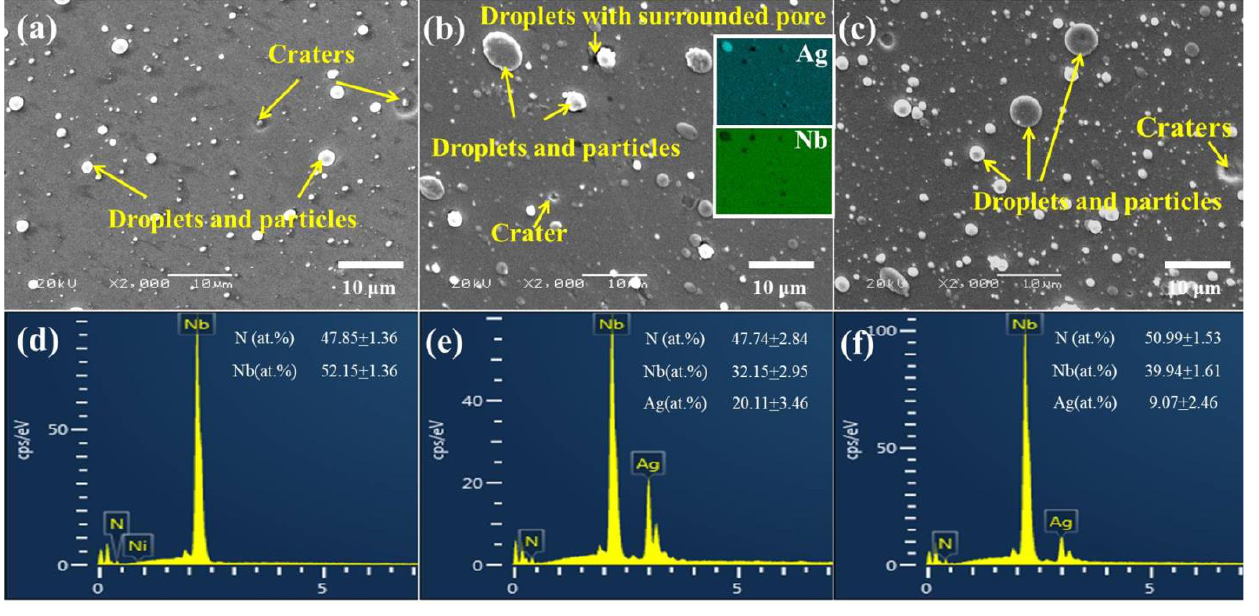
Figure 1. Surface morphologies and chemical compositions of the films: ( a , d ) NbN; ( b , e ) NbN-Ag; ( c , f ) NbN/NbN-Ag.